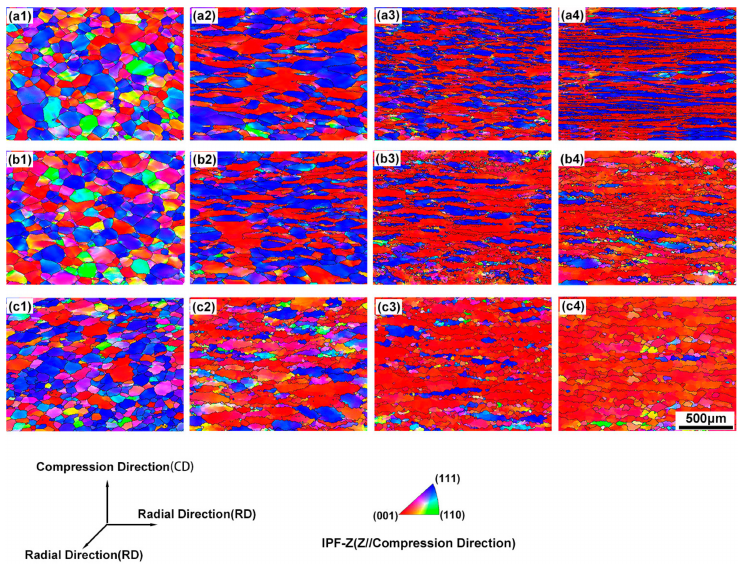
Figure 2. Orientation maps with IPF (inverse pole figure) colors by EBSD (electron backscatter diffraction) under different parameters: ( a 1)–( a 4) are under 1 s − 1 with 20%, 40%, 60%, and 80% reduction; ( b 1)–( b 4) are under 0.1 s − 1 with 20%, 40%, 60%, and 80% reduction; ( c 1)–( c 4) are under 0.01 s − 1 with 20%, 40%, 60%, and 80% reduction; the compressing temperature is 1153